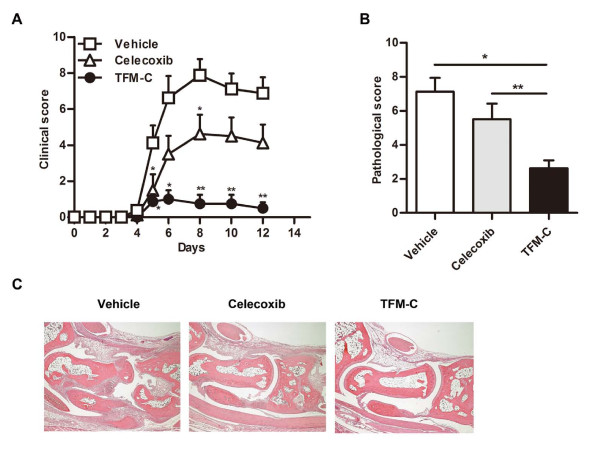
The effect of TFM-C on CAIA. A. Clinical scores of CAIA in B6 mice treated with 10 μg/g TFM-C (closed circles), celecoxib (open triangles) or vehicle (open squares) every other day from two days before CAIA induction. * P < 0.05 compared with control group, * P < 0.05 compared with both control and celecoxib-treated groups. Results shown are the mean + SEM of five mice per group. The data shown are from a single experiment representative of two similar experiments. B. Quantification of histological assessment of joints 12 days after induction of AIA shown in A. Results shown are the mean + SEM of five mice per group. * P < 0.05 control versus TFM-C group, * P < 0.05 celecoxib versus TFM-C -treated group. C. Representative histological feature of joints in vehicle-treated (left), TFM-C-treated (middle) and celecoxib-treated (right) mice. (H&E stained; original magnification × 40).